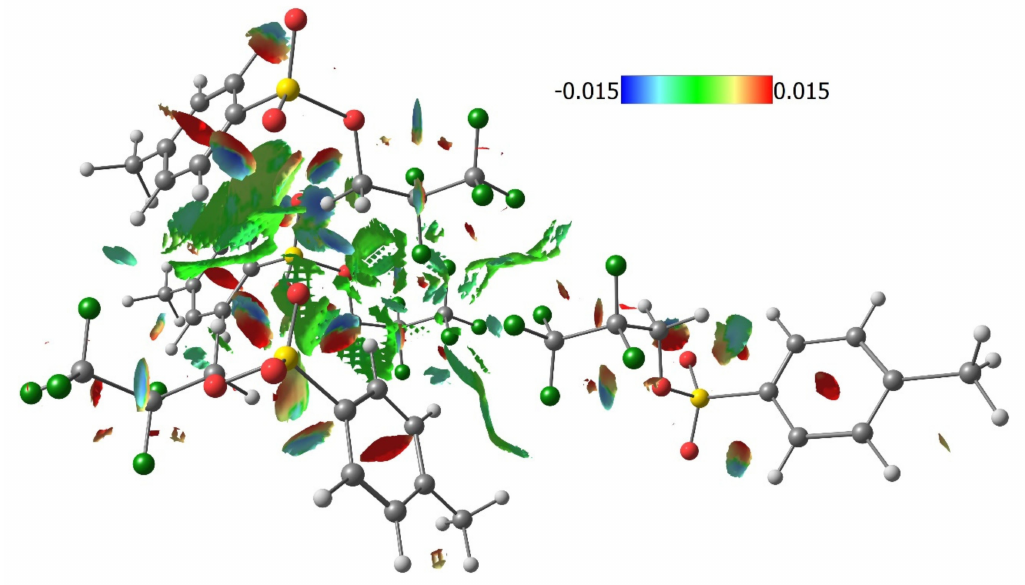
Figure 10. 3D surface of RDG (0.6 a.u.) colored according to sign( λ 2 ) ρ function in 1 illustrating the interaction between CF 3